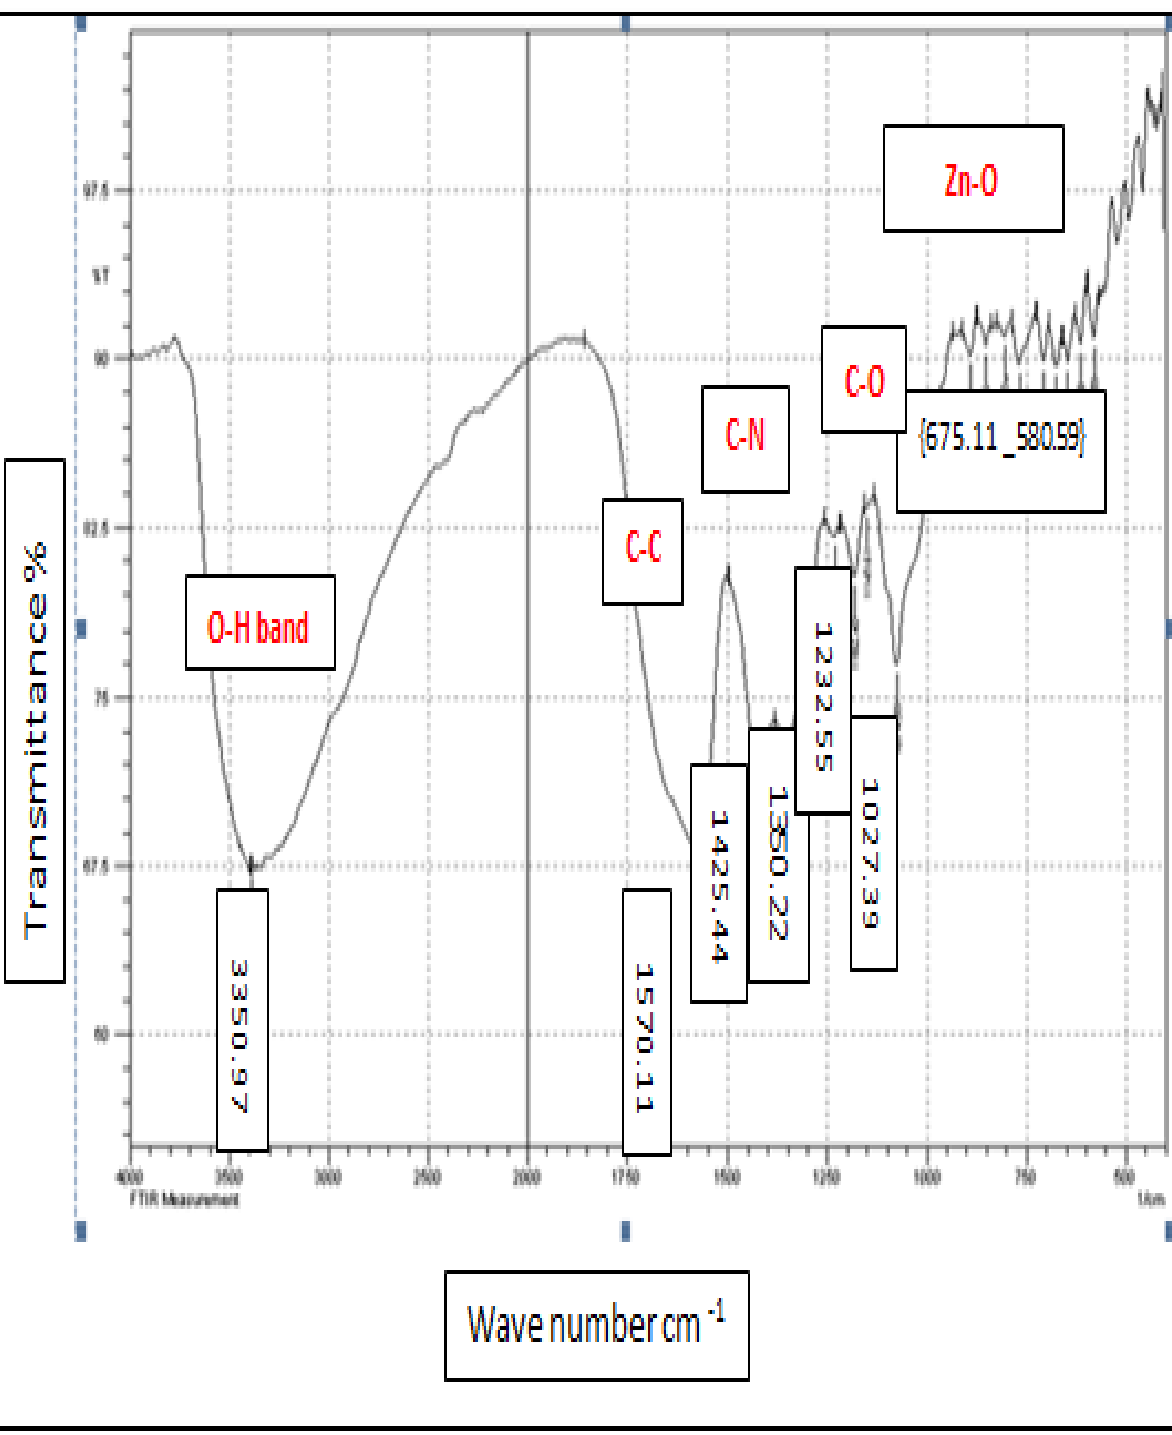
Figure 4. FT-IR Spectrogram for the ZnONPs synthesized by